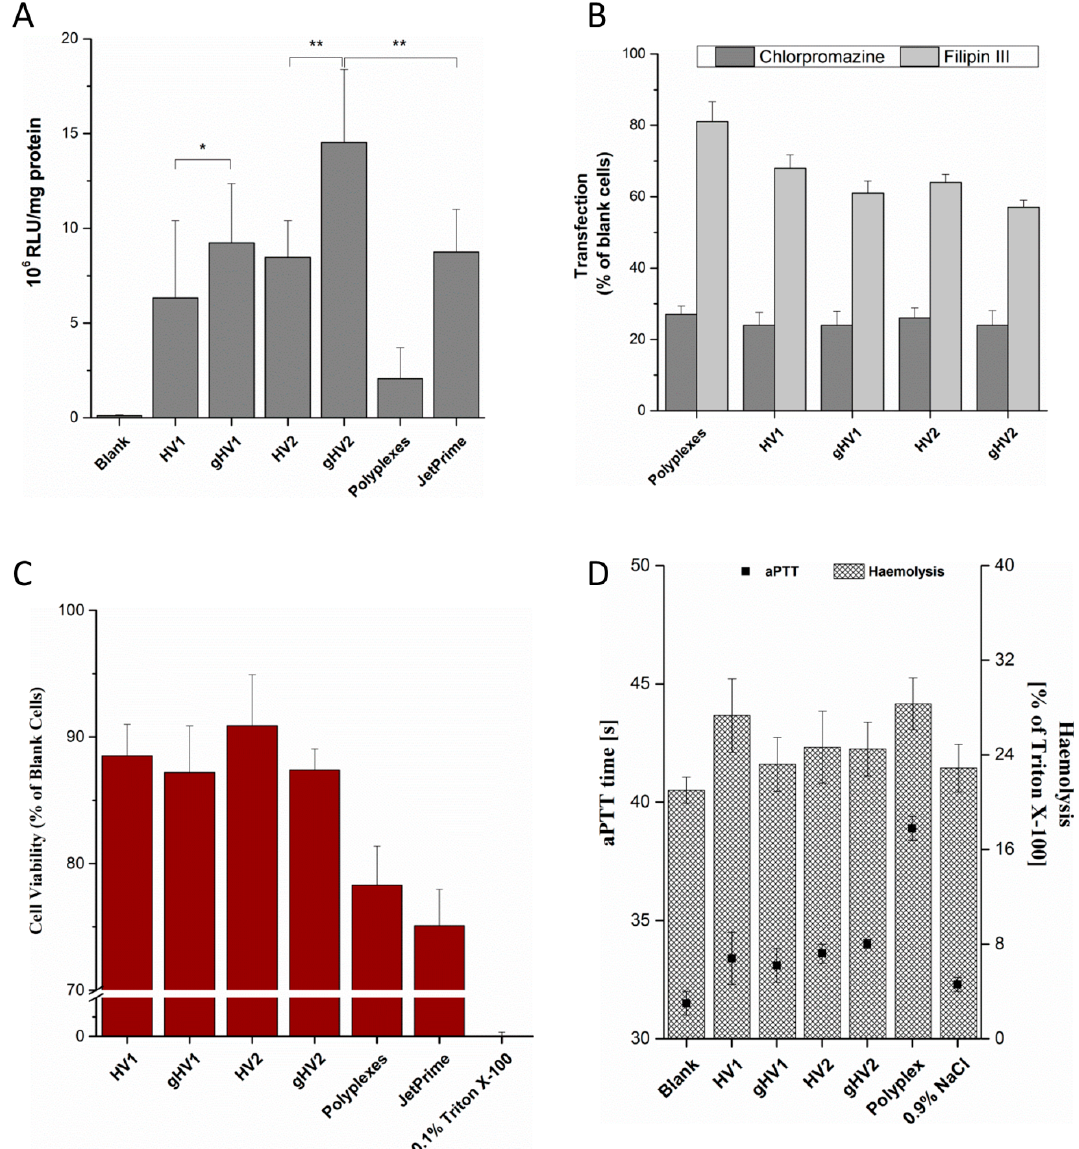
Figure 2. ( A ) Transfection efficiency (luciferase reporter assay) of the hybrid vectors in a SK-OV-3 cell line. Blank denotes untreated cells. Data are expressed in relative luminescence units per mg protein (evaluated using a Pierce BCA assay). JetPrime, a commercially available polymer-based transfection reagent, was used a control for the transfection studies; ( B ) uptake pathway inhibition of the hybrid vectors in the presence of either 5 µM of chlorpromazine or 3 µM of Filipin III in a SK-OV-3 cell line. Blank cells (y-axis) denote the transfected cells without pathway inhibitors. Values are denoted as percentages of the luciferase expression of cells transfected with their respective vectors (either polyplexes or hybrid vectors); ( C ) MTT assay of the hybrid vectors in a SK-OV-3 cell line. Cell viability is expressed as the percentage of blank cell viability, with 0.1% Triton X-100 as a positive control; ( D ) haemolysis and activated partial thromboplastin time test of the hybrid vectors using erythrocytes and blood plasma, respectively, with 0.9% NaCl as a control. Blank denotes untreated erythrocytes in the case of haemolysis and untreated plasma in the case of the aPTT test. HV1 and HV2 denote the hybrid vectors with lipid composition mimicking that of HIV and HSV, respectively, and gHV1 and gHV2 denote their glycosylated counterparts.